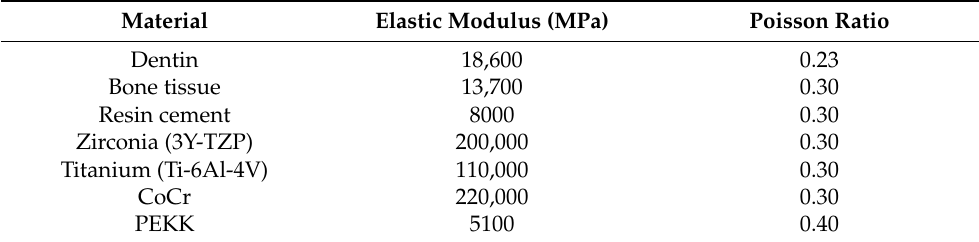
Table 1. Mechanical properties of the materials/solid geometries used in the current study.